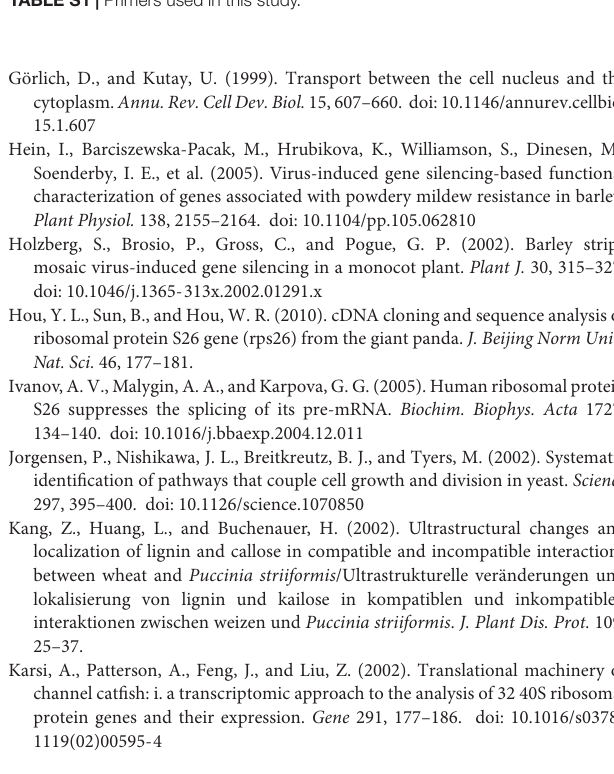
TABLE S1 | Primers used in this